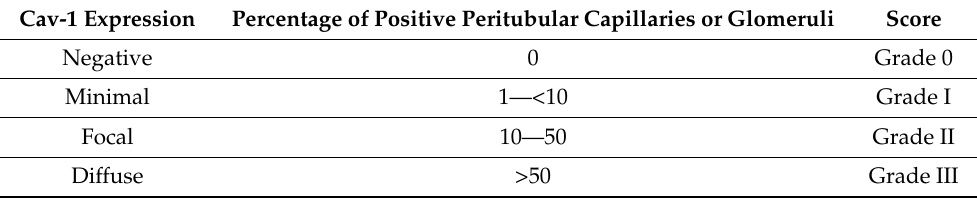
biopsies were first evaluated with hematoxylin and eosin to identify the most